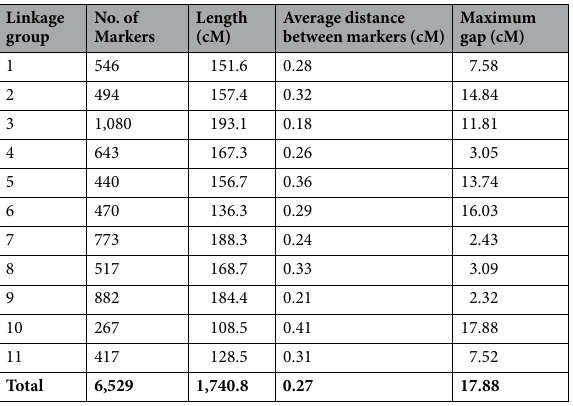
Table 1. Features of the high-density genetic linkage map constructed for the Vigna vexillata F 2 population of a cross between ‘TVNu 240’ and ‘TVNu1623’ using SNP markers generated by SLAF sequencing.